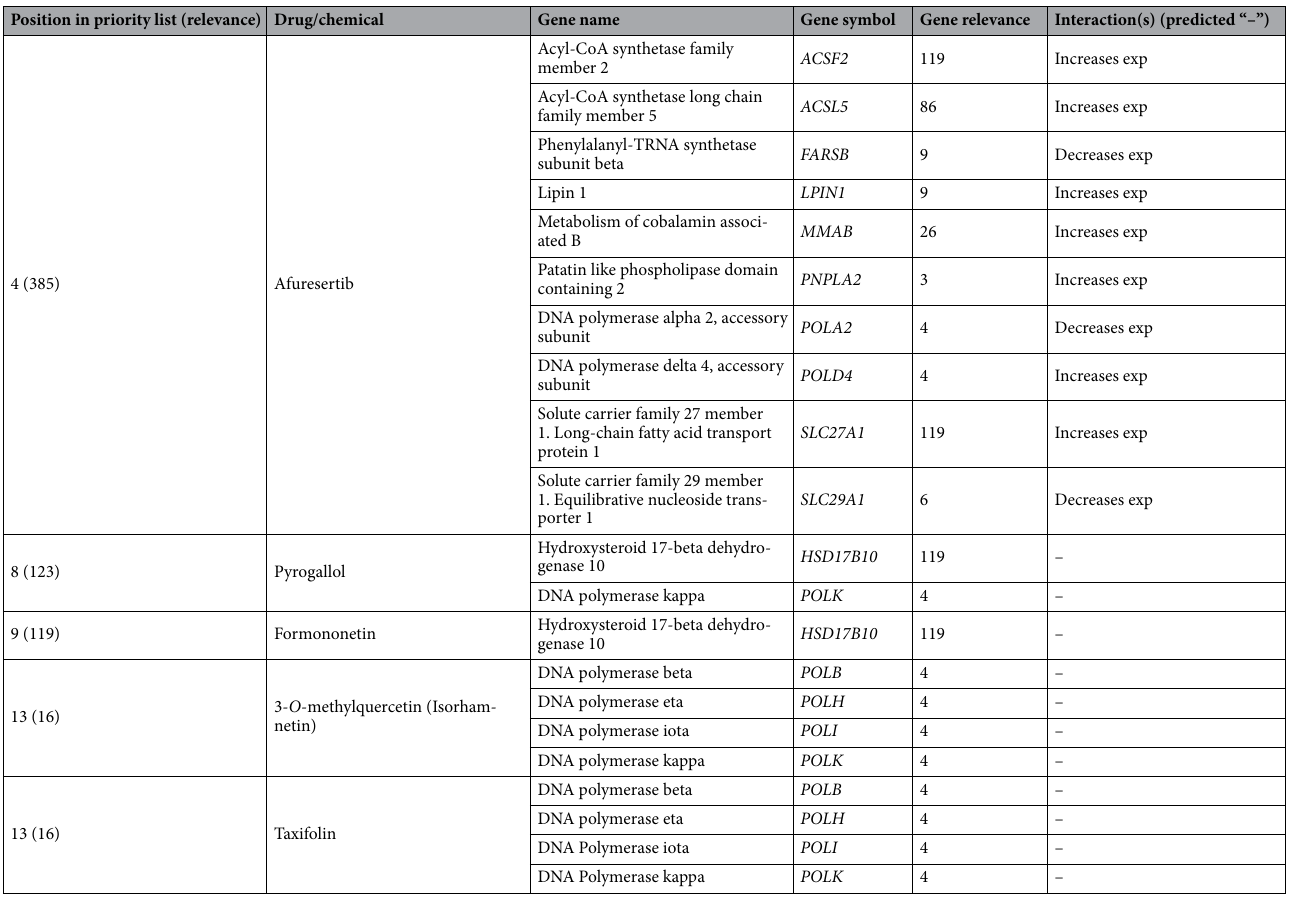
Table 1. Selected chemicals from the priority list for in vitro testing. Interactions for afuresertib were derived from Comparative Toxicogenomics Database (CTD) Oct 2020 46 , and interactions for all other compounds derived from The Drug-Gene Interaction database (DGIdb) Nov 2020, v4.2.0 45 . Gene relevance refers to the summation of the occurrence (extended choke point) and the topological importance (centrality score by PageRank). The stoichiometry of a reaction related to ACSF2 can be found in Supplementary Table